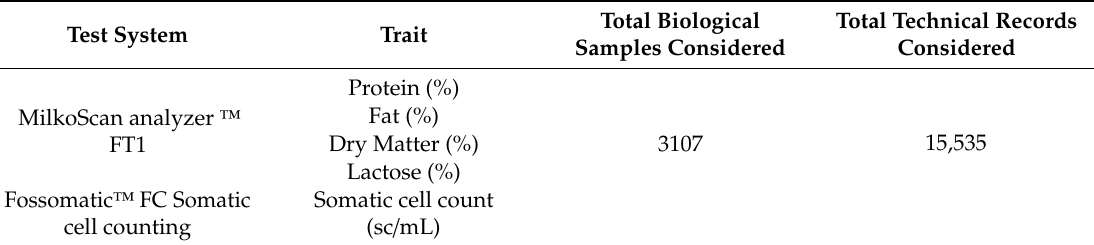
Table 1. Record number